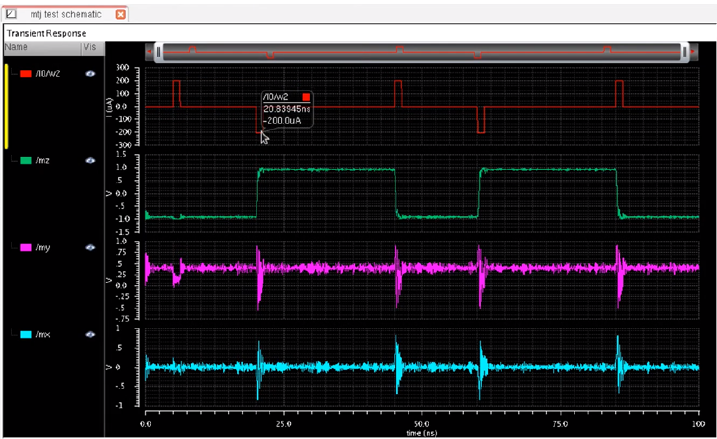
Figure 11. Simulated waveform of an MRAM cell.